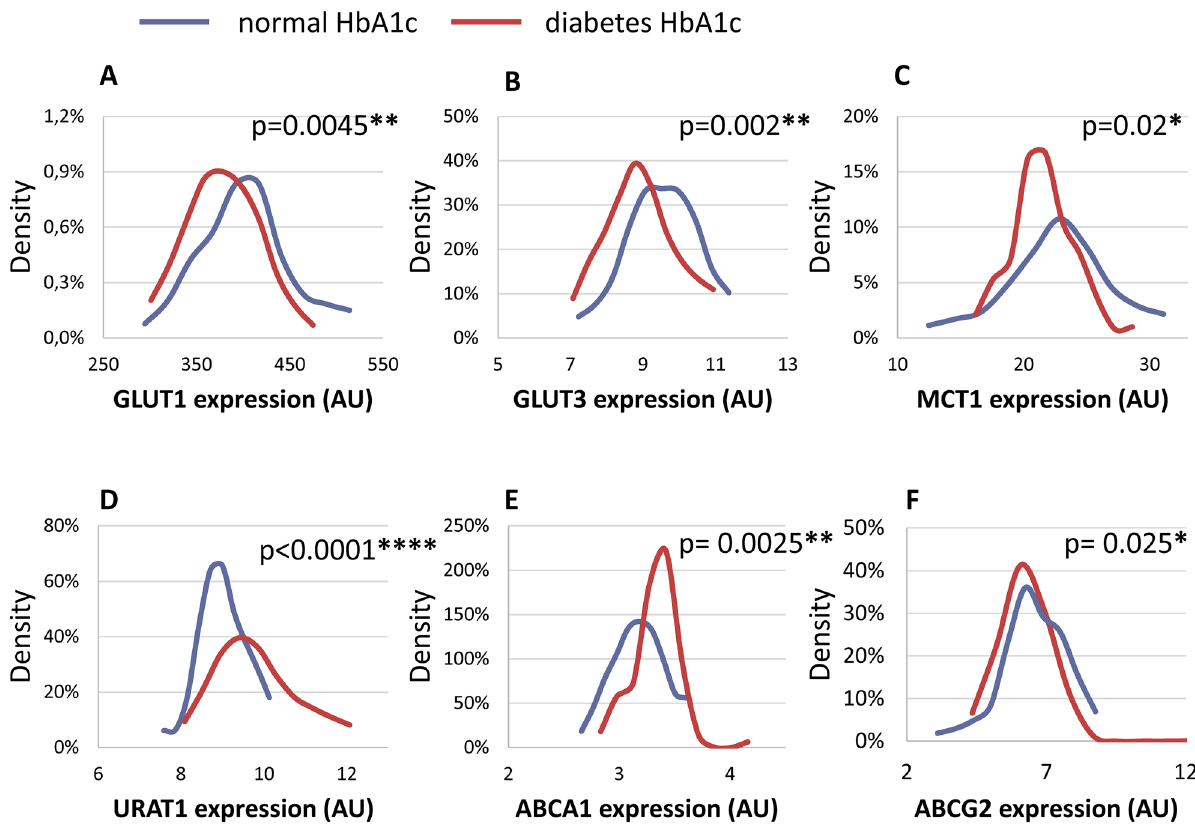
Figure 4. Kernel density diagrams and the p values obtained for the statistical differences between the protein expression levels within the groups with normal HbA1c (n = 55, except for MCT1, n = 50), versus highly increased HbA1c levels (HIL—n = 64, except for MCT1, n = 59). Blue: normal, < 5.6% HbA1c, red: HIL, > 6.5% HbA1c. The p values were calculated by Mann–Whitney test. Expression levels of ( A ) GLUT1; ( B ) GLUT3; ( C ) MCT1; ( D ) URAT1; ( E ) ABCA1, and ( F )